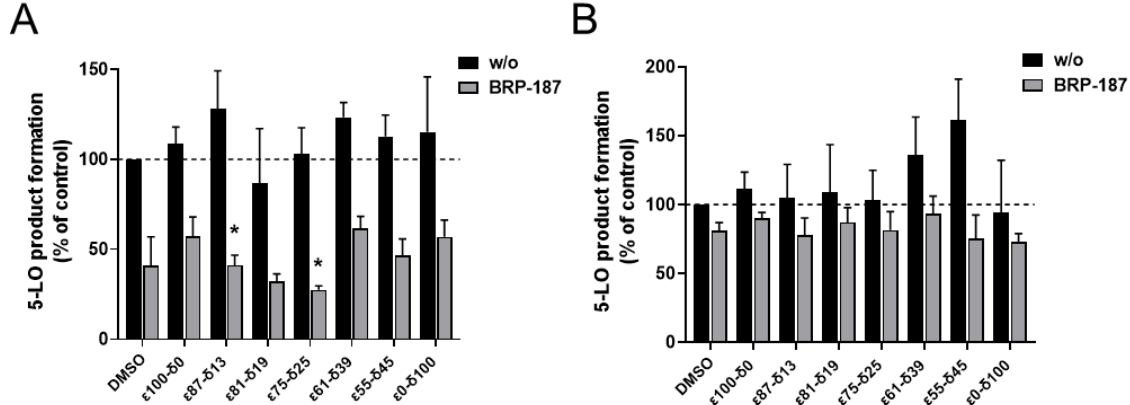
Figure 4. Measurement of 5-LO product formation as an indicator for the inhibition of the drug target FLAP by BRP-187 [36]. PMNL preincubated with DMSO, BRP-187 (0.3 µM), empty PCL particles (labeled as w/o) or PCL particles with BRP- 187 (labeled with BRP-187; 0.3 µM respective BRP-187) for 15 min ( A ) or 5 h ( B ) at 37 °C. Values are given as 5-LO products as a percentage of control (DMSO) (n = 3). Statistical analysis was performed via one-way ANOVA and Tukeys multi comparison test with logarithmic transformed data (* p<0.05).